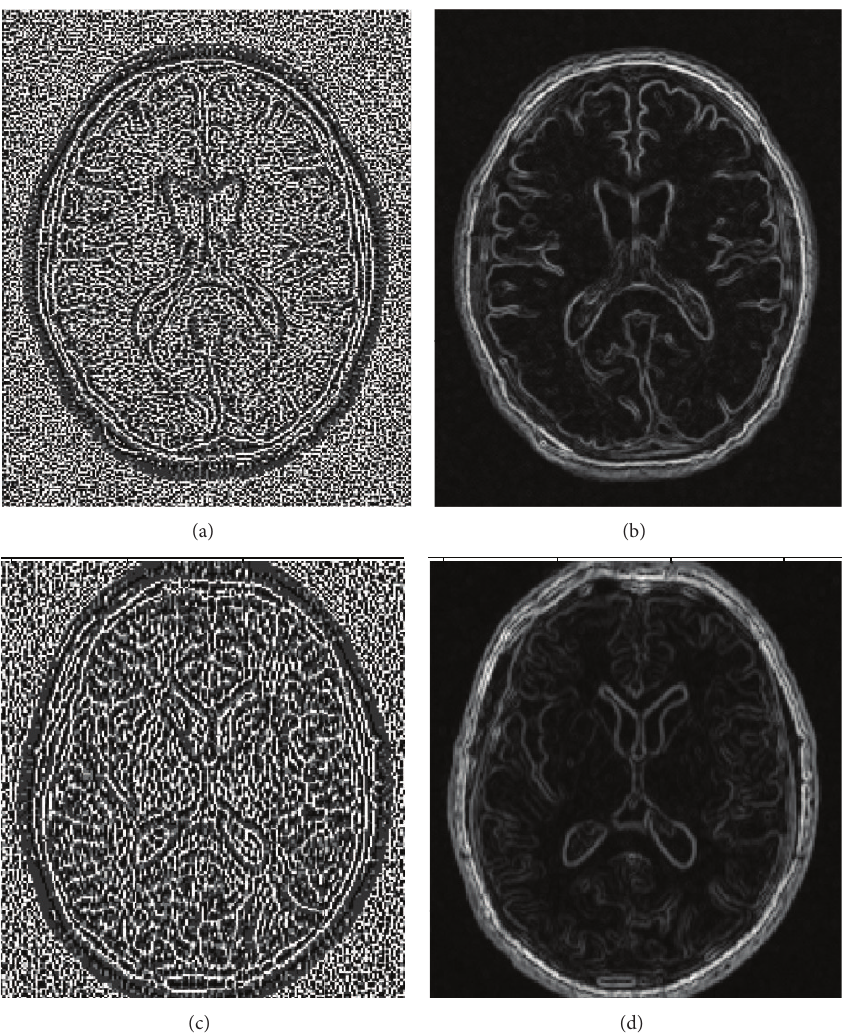
Figure 4: Overview of LBP texture- and contrast-valued images based on the FLAIR and T1 images. (a) in the top left corner shows an example of an LBP-valued image calculated from a FLAIR MR image. (b) in the top right corner shows a contrast-valued image calculated from FLAIR MRI. (c) in the bottom left corner shows an LBP-valued image calculated from a T1 image. (d) in the bottom right corner shows a contrast-valued image calculated from a T1 MR